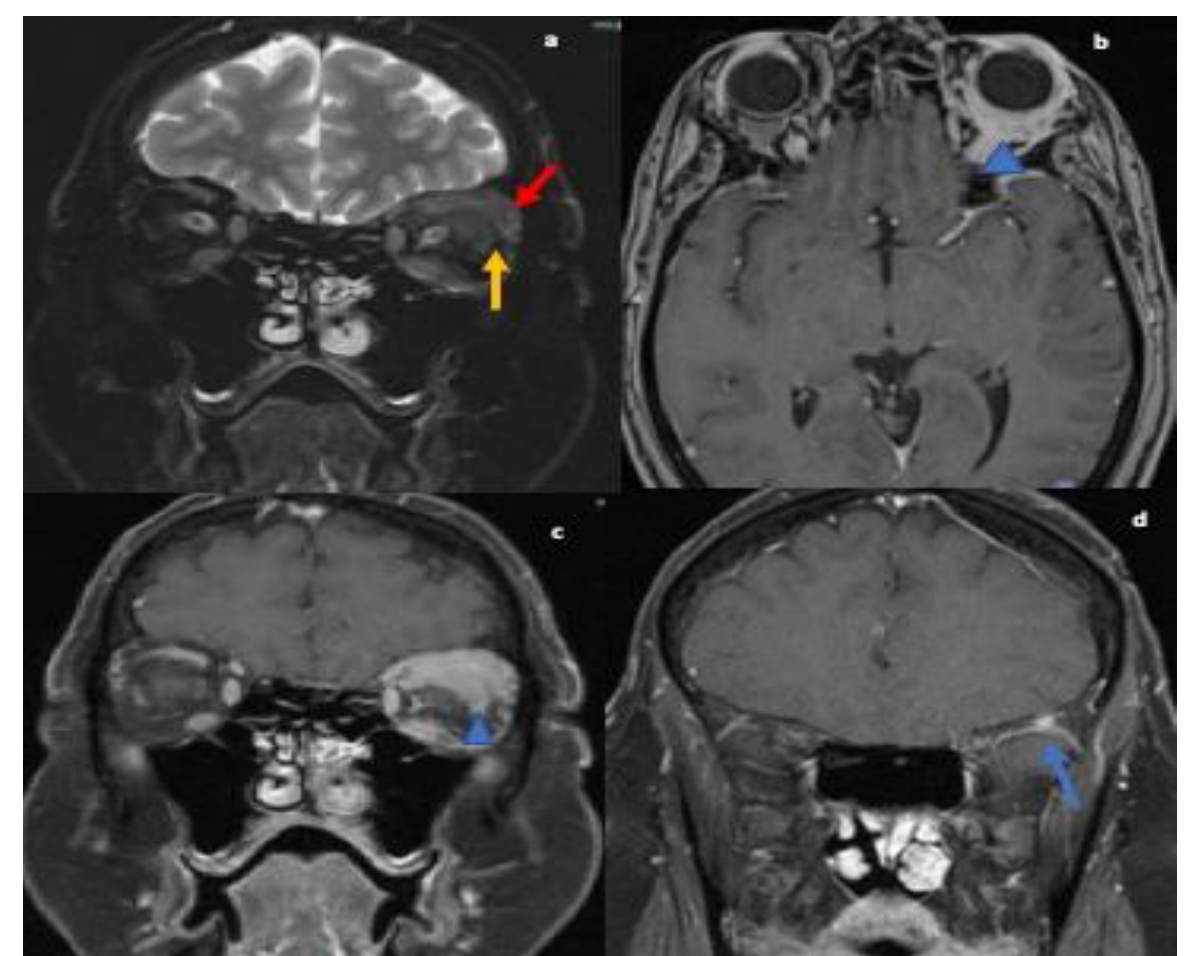
Figure 2. MRI orbit T2 fat-suppressed coronal images reveals nodular thickening of the left lacrimal gland (red arrow; ( a )), superior and lateral recti muscles (yellow arrow; ( a )). T1-weighted post contrast axial ( b ) and coronal images ( c ) showing corresponding enhancement within muscles, lacrimal gland and in intraconal orbits surrounding the globe (blue arrowhead).T1 weighted post contrast coronal image ( d ) reveals enhancing nodule in the greater wing of left sphenoid concerning for osseous involvement (blue arrow).